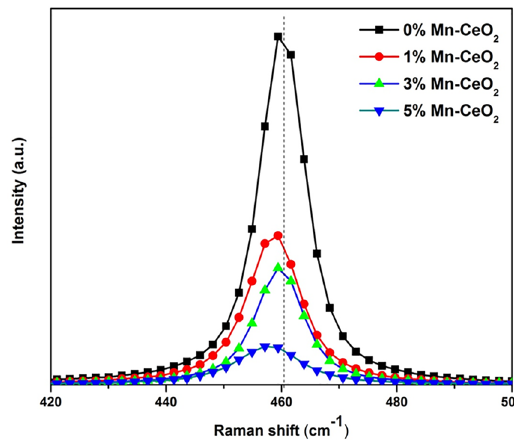
Figure 4. Raman spectra of Mn/CeO